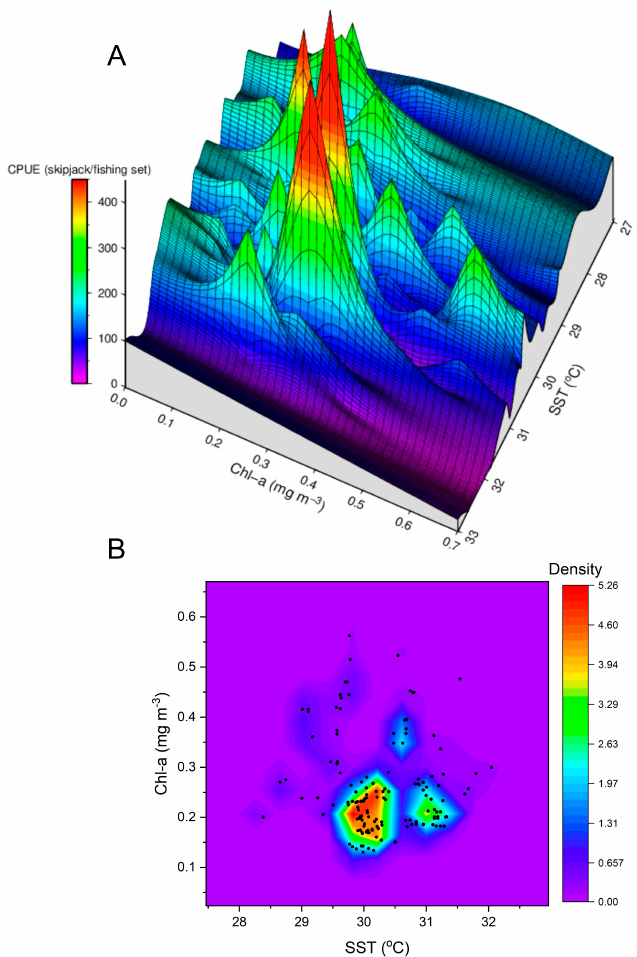
Figure 4. Three-dimensional relationship between GAM predicted skipjack CPUE (catch per unit effort) ( A ) and the 2D relationship between KDE fishing sets and satellite data, SST, and Chl-a at the fishing ground spots ( B